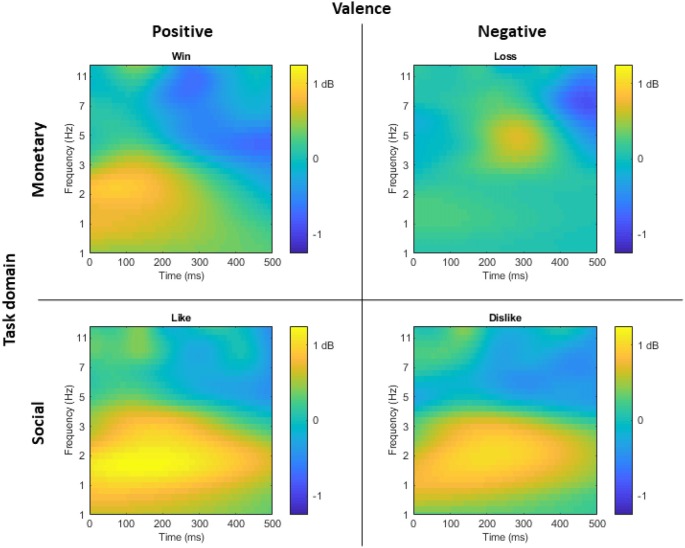
For visual display of time-frequency representation of the task-effect, time-frequency plots displaying the difference at FCz between correct and incorrect trials for monetary win, monetary loss, social like, and social dislike tasks, respectively. Yellow indicates greater activity for correct compared to incorrect trials, while blue indicates greater activity for incorrect compared to correct trials.